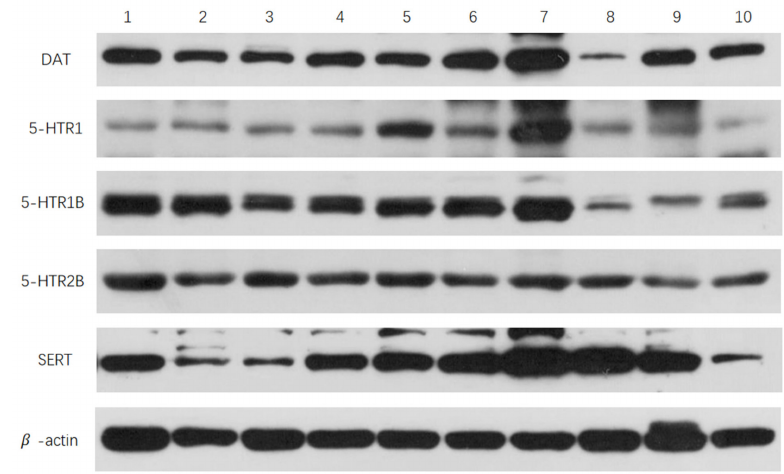
Figure 4. Effects of sulpiride and clozapine on protein expression levels of functional molecules of DA and 5-HT neurotransmitter systems in octopus brain tissue. Note: 20 ng/L clozapine exposure group; 2. 50 ng/L clozapine exposure group; 3. 100 ng/L clozapine exposure group; 4. 20 ng/L sulpiride exposure group; 5. 50 ng/L sulpiride exposure group; 6. 100 ng/L sulpiride exposure group; 7. 20 ng/L (sulpiride + clozapine) mixed exposure group; 8. 50 ng/L (sulpiride + clozapine) mixed exposure group; 9. 100 ng/L (sulpiride + clozapine) mixed exposure group; 10. control group.